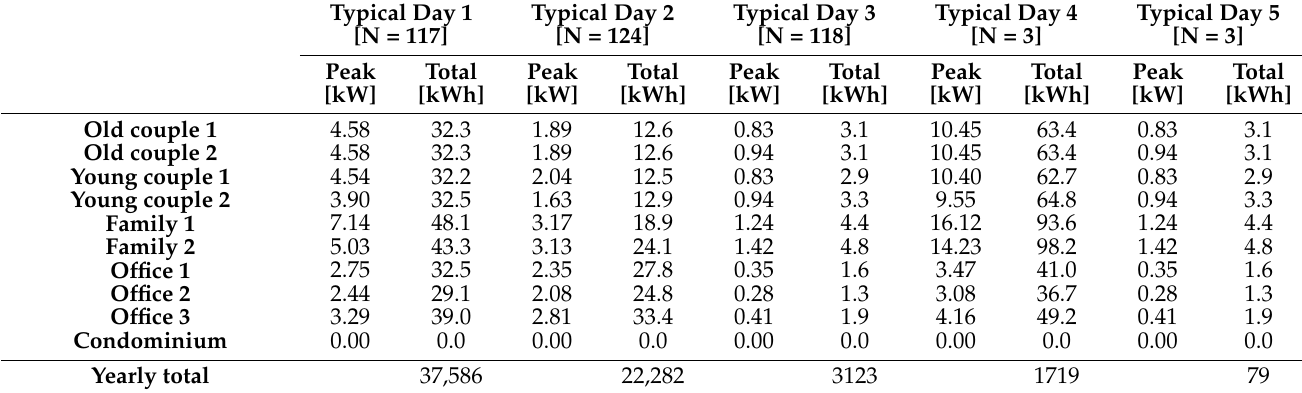
Table 4. Heating demand (space heating + domestic hot water) for each apartment in each typical day, in terms of peak and total heating demand during the day. The yearly total demand is calculated by multiplying the total heating demand of each typical day for its cardinality (N, according to the nomenclature used in Equation (6)).